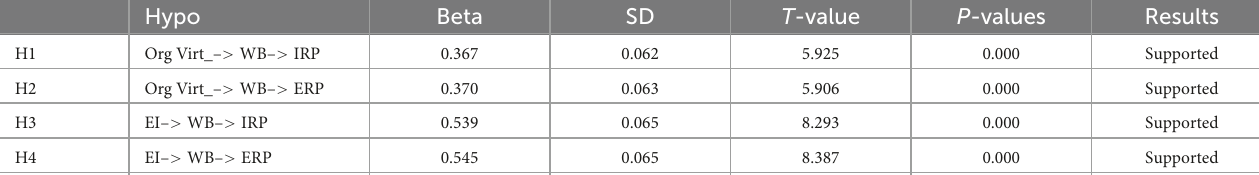
TABLE 7 Hypothesis